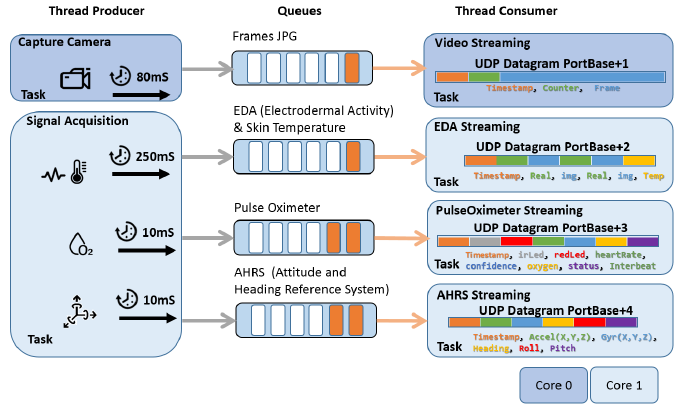
Figure 12. General description of the software and firmware of the developed